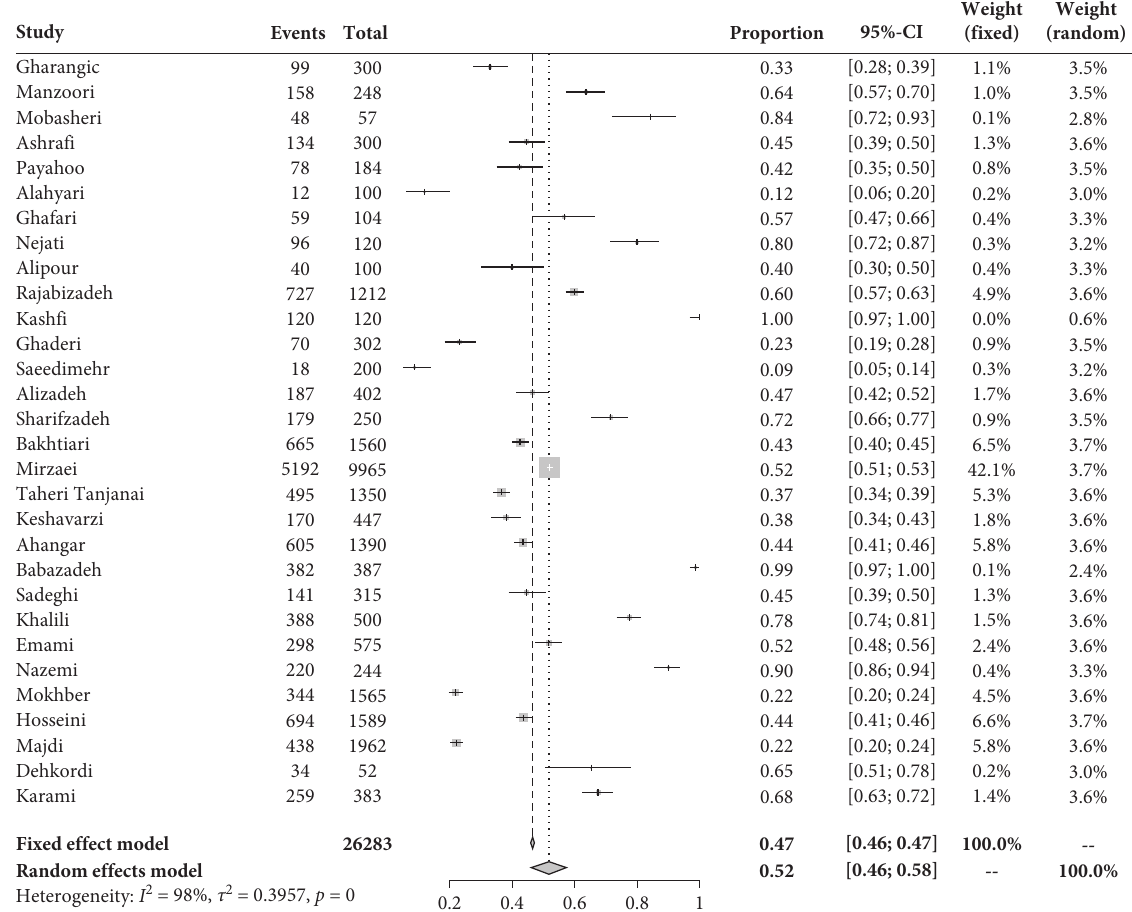
Figure 2: Forest plot of the selected